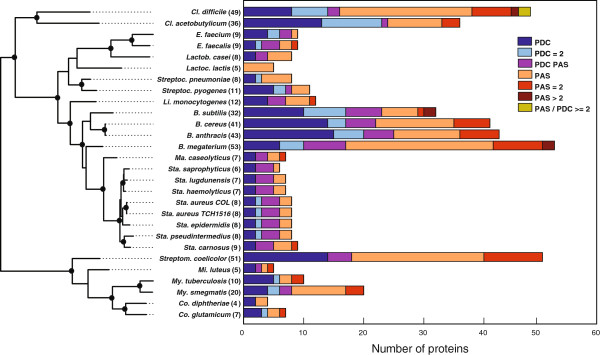
Overview of PDC/PAS proteins in 28 Gram-positive bacteria. The total number of PDC/PAS proteins found in each genome is shown in parentheses next to the species name and its corresponding bar length. Ranges of different colors in each bar indicate the proportions of different domain architectures. They include "single PDC" (dark blue: PDC), "two PDCs" (light blue: PDC = 2), "PDC and PAS" (purple: PDC PAS), "single PAS" (orange: PAS), "two PASs" (red: PAS = 2), "more than two PASs" (brown: PAS > 2), and "multiple PAS and PDC" (yellow green: PAS/PDC > =2). See (Additional file 1: Table S1) for the details. On the left hand side, the maximum likelihood phylogeny of 16S rDNA sequences is given to provide an evolutionary relationship among these bacteria. Dark circles at internal nodes represent those supported by bootstrap values greater than 70%.